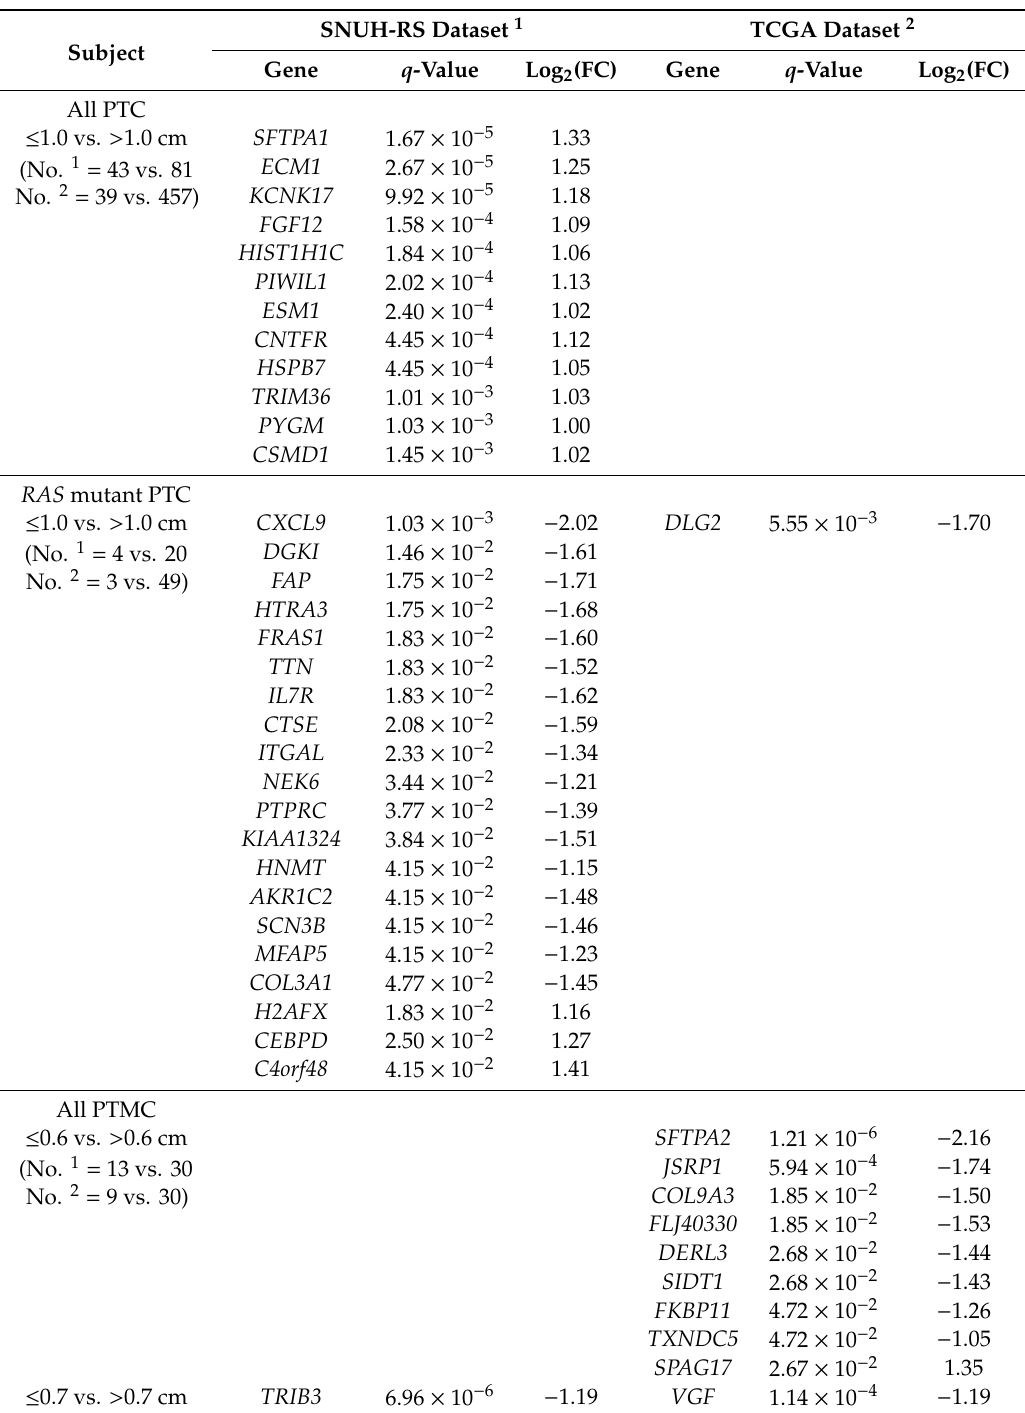
Table 3. Di ff erentially expressed genes between papillary thyroid microcarcinoma (PTMC) and papillary thyroid carcinoma (PTC) > 1 cm, and according to PTMC